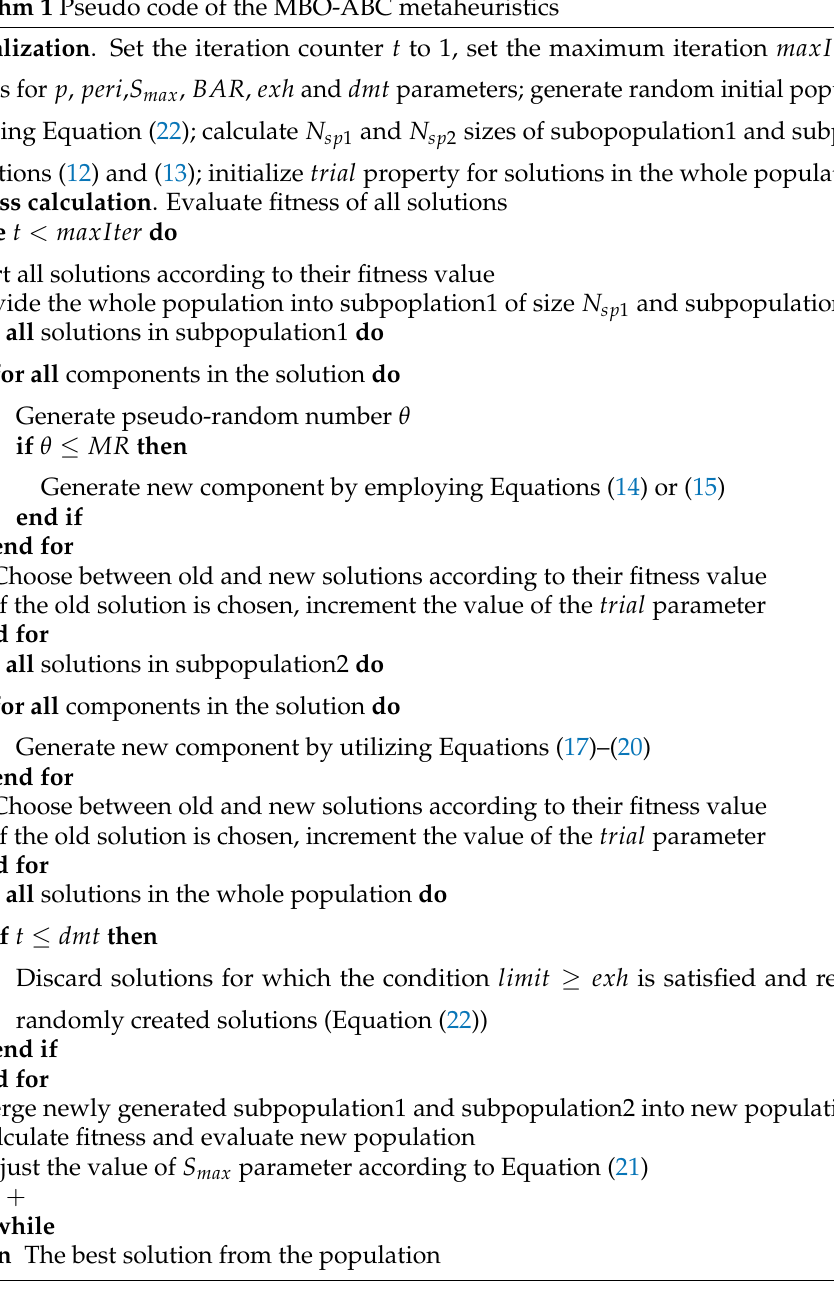
Algorithm 1 Pseudo code of the MBO-ABC